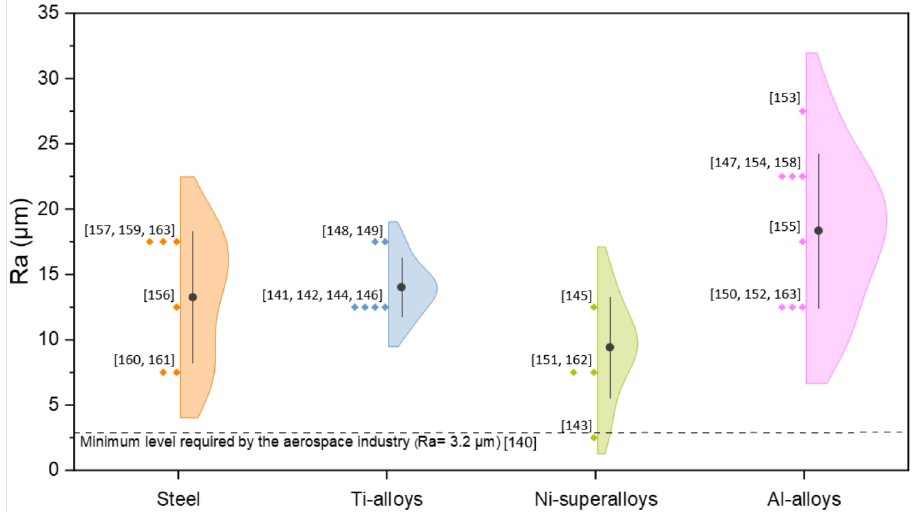
Figure 11. Plot of surface roughness as a function of the main categories of commercially available materials for PBF-LB/M production